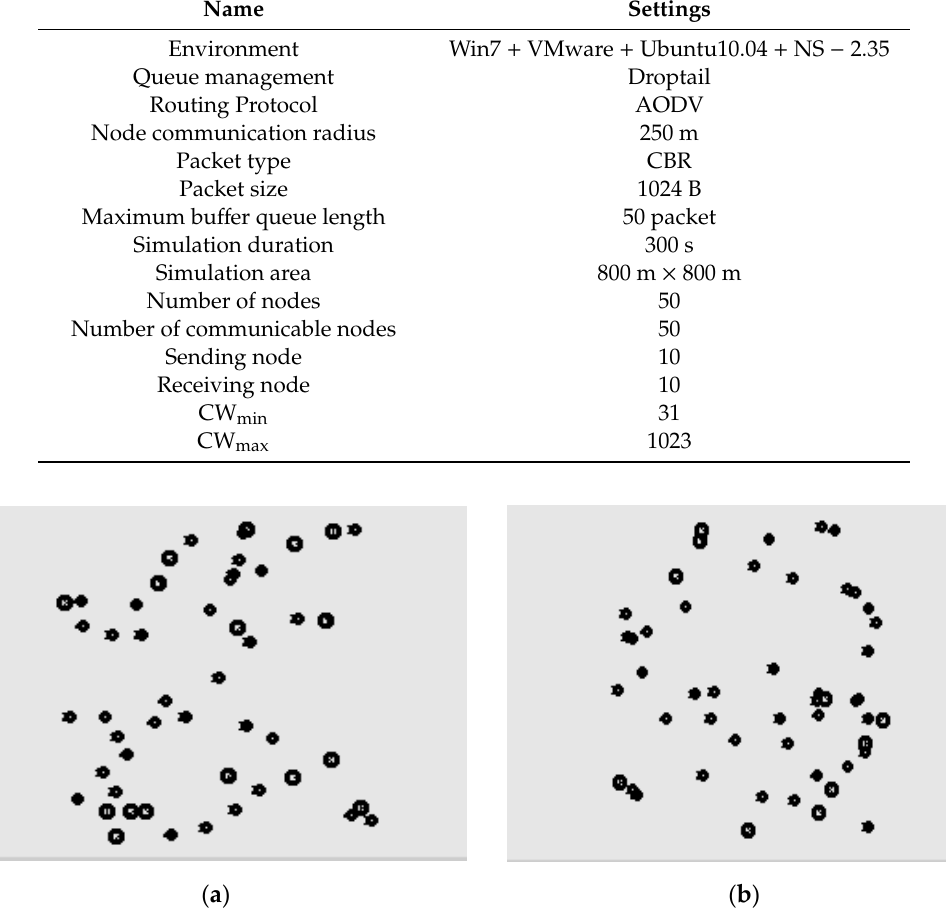
Figure 14. Two random network topologies. ( a ) Random network topology 1; ( b ) Random network topology 2.